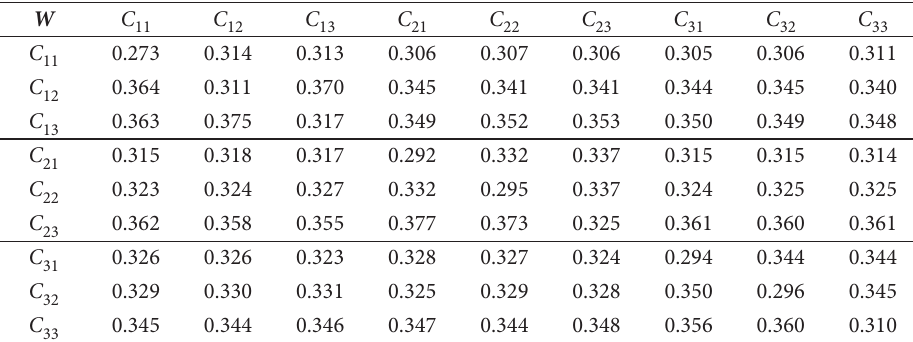
Table 8. The un-weighted